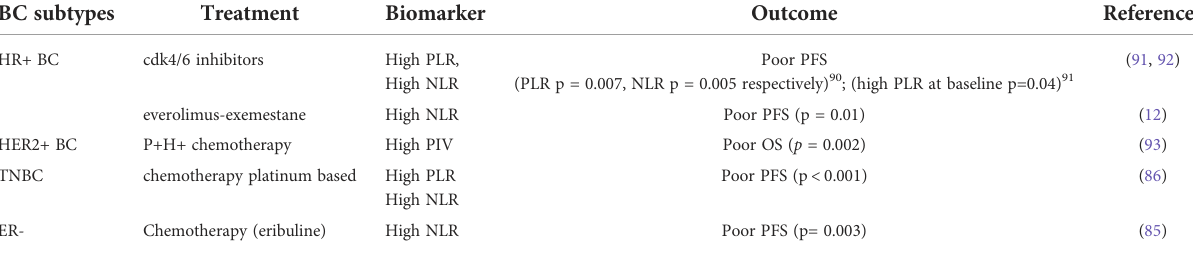
TABLE 2 Prognostic role of circulating biomarkers in response to treatments in aBC, available results from retrospective analysis. BC